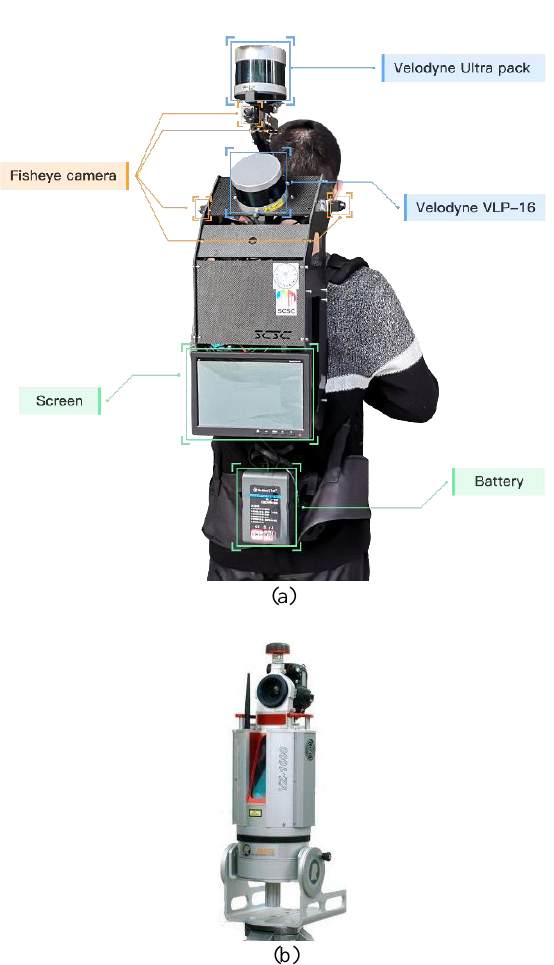
Figure 1. Data acquisition devices.